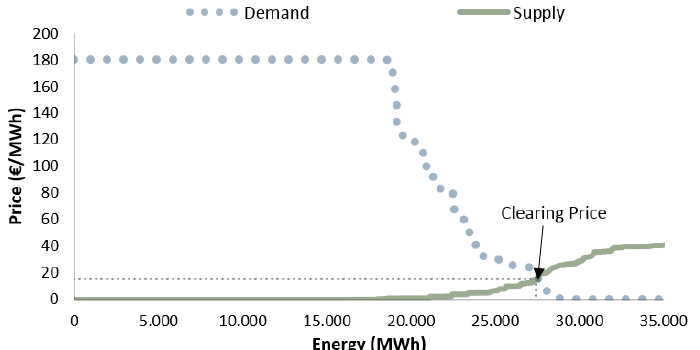
Figure 1. The clearing price determination during an hour.